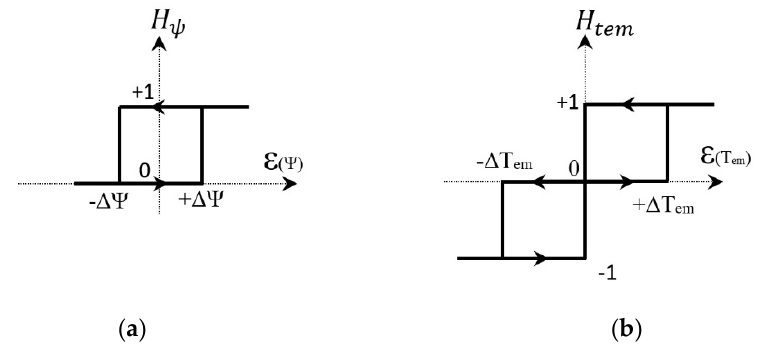
Figure 2. ( a ) Torque hysteresis comparators of three-level ( b ) flux comparators of two-levels.